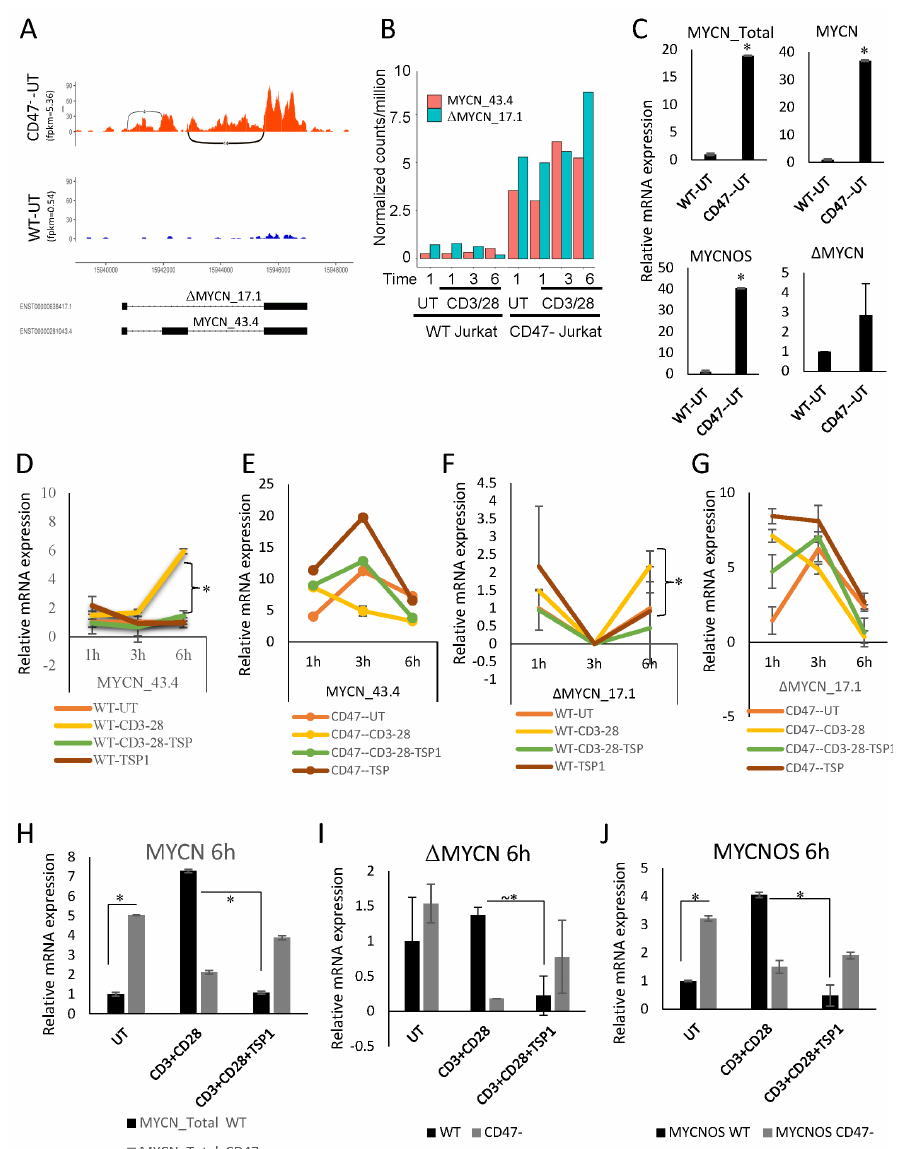
Figure 3. CD47-dependent regulation of MYCN splice variants. ( A ) Sequence coverage for unspliced and two isoforms, ENST00000281043.4 (MYCN_43.4) and ENST00000638417.1( ΔMYCN _17.1), in unstimulated WT and CD47 − Jurkat cells. ( B ) Normalized CPM for MYCN 43.4 and Δ MYCN_17.1 isoforms in untreated (UT) WT and CD47 − Jurkat cells and cells activated on anti-CD3 plus CD28 for the indicated times. ( C ) MYCN isoform mRNA expression in untreated Jurkat cells determined by real-time PCR using specific primers normalized to B2M. ( D–G ) mRNA expression of MYCN splice isoforms (common MYCN_43.4 and Δ MYCN_17.1) during WT and CD47 − Jurkat cell activa- tion using CD3 plus CD28 antibodies in the presence or absence of 1 μg/mL TSP1 for 1, 3, and 6 h via real-time PCR. 18S ribosomal RNA primers (n=2, replicates) were used as the control for nor- malization. Error bars indicate technical replicates for total MYCN and ΔMYCN ( n = 3). ( H–J ) Jurkat (JK) and CD47 − JinB8 cells were plated on anti-CD3 and CD28 coated plates in the presence or ab- sence of 1 μg/mL TSP1 for 6 h. Relative expression of Δ MYCN, MYCNOS, and total MYCN at 6 h was normalized to 18S ( n = 3, technical replicates).